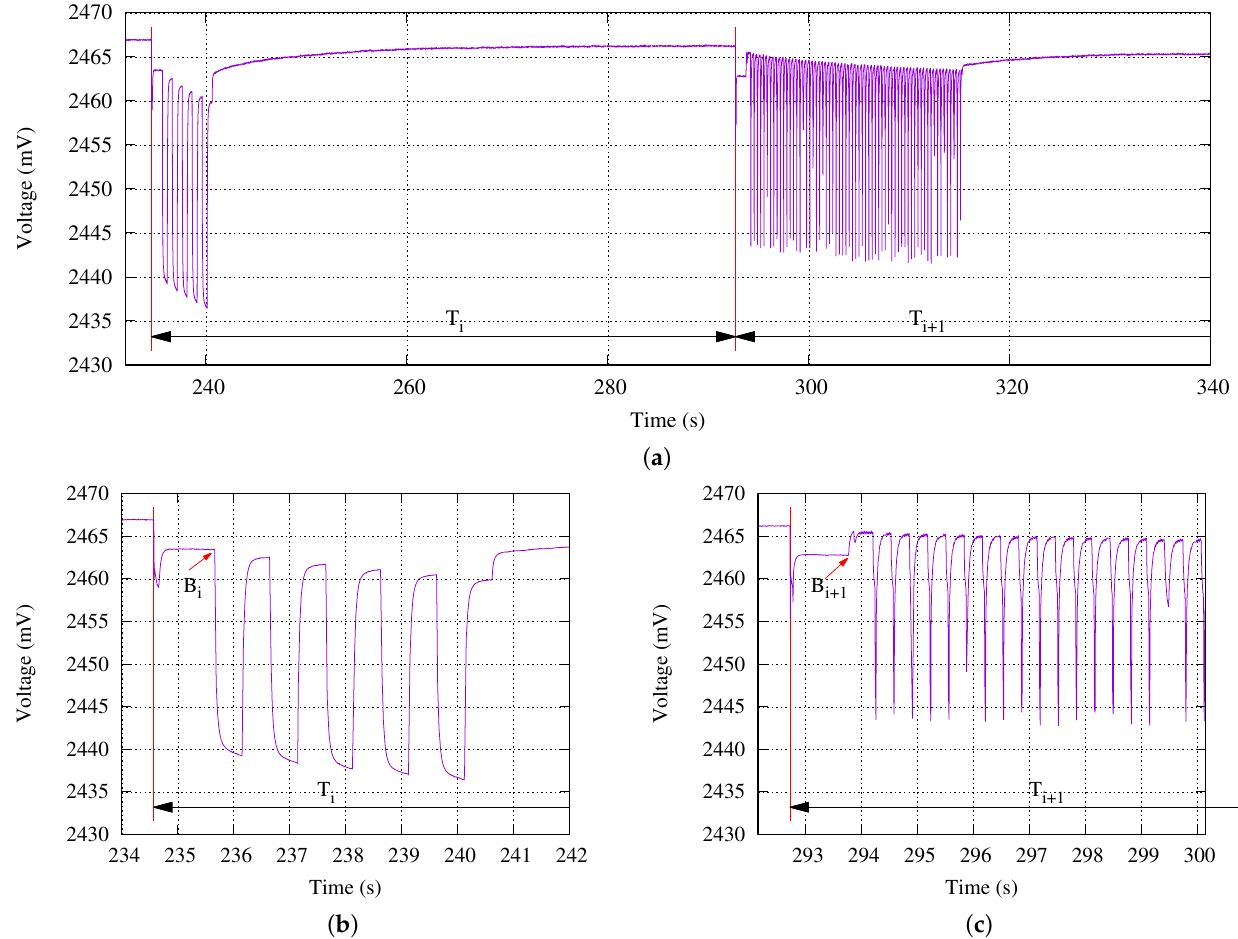
Figure 9. Two consecutive iterations experiment: ( a ) Measured battery voltage, ( b ) turbidity measurement, and ( c ) acceleration